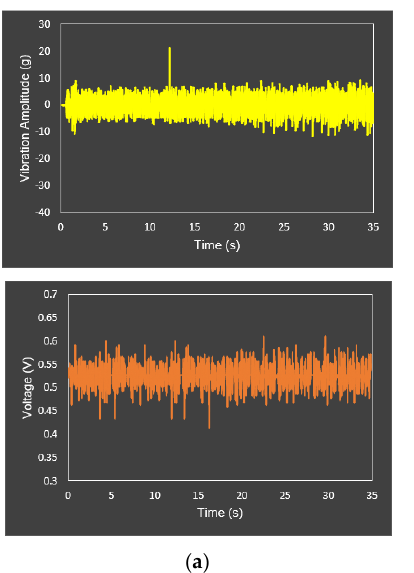
Figure 16. CPMA applicated to two different machines: ( a ) first machine and ( b ) second machine.